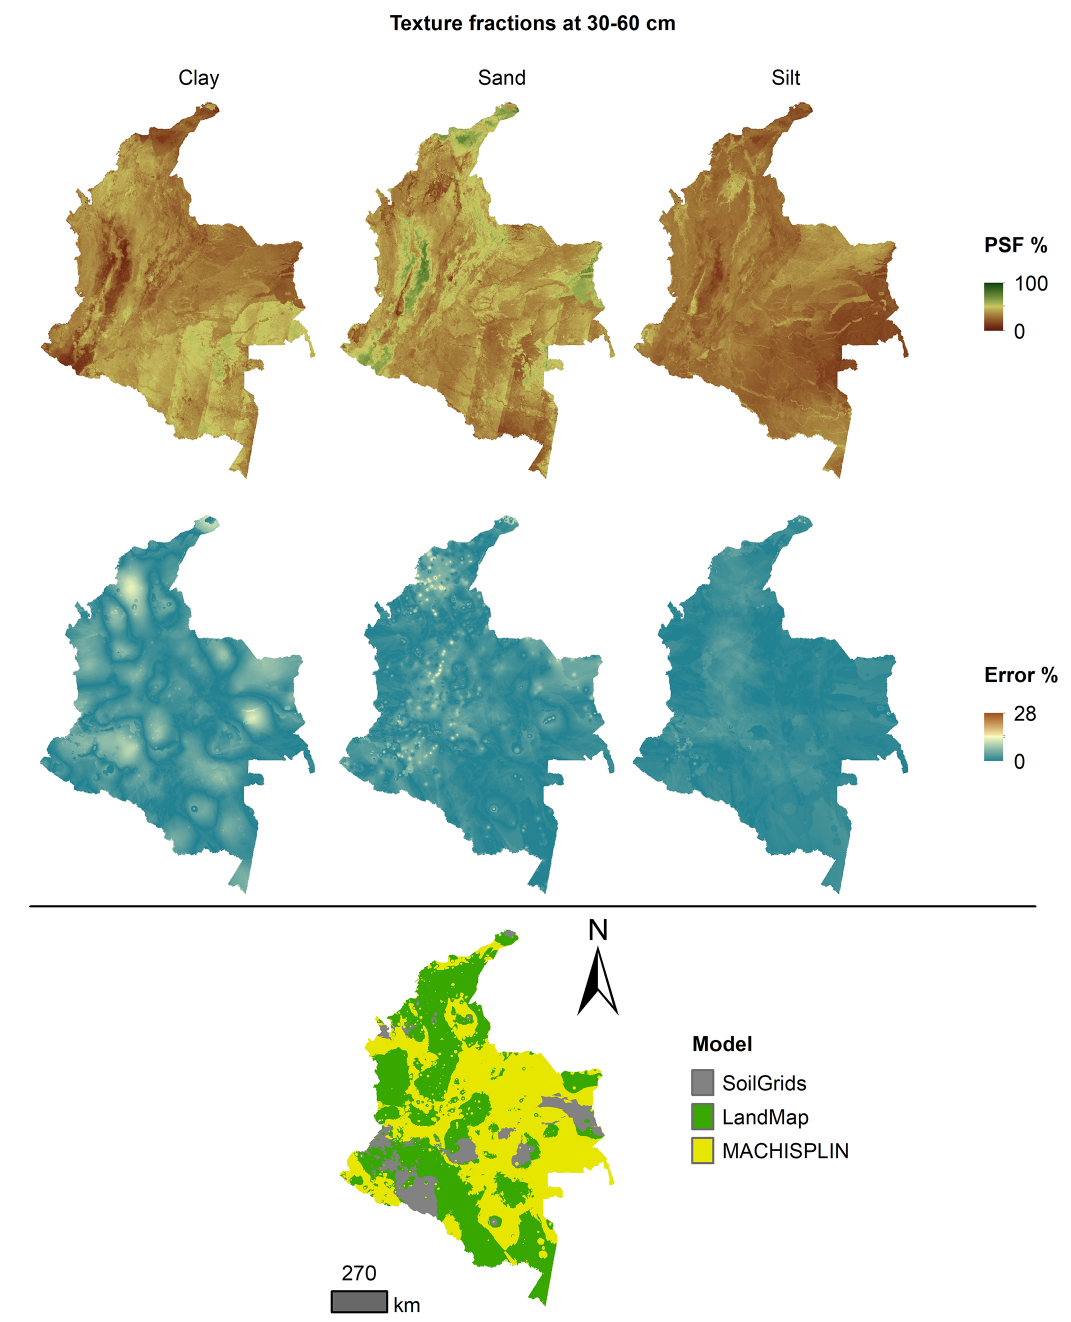
Figure 8. Ensemble model, percentage error distribution, and best model selected at